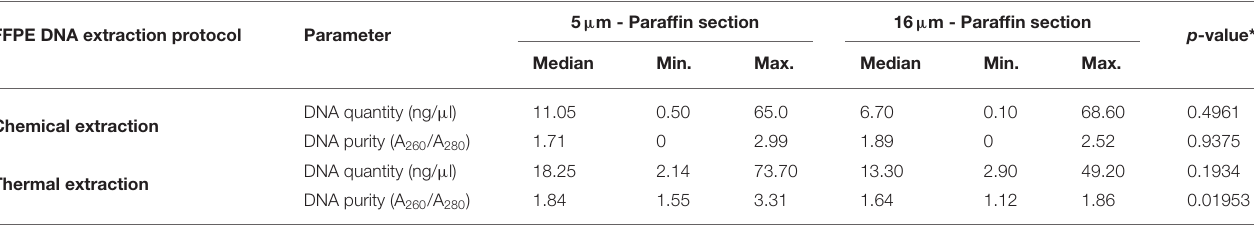
TABLE 2A | Comparison of chemical and thermal DNA extraction protocols in clinical FFPE skin samples from ten cats, using the two paraffin sectioning protocols (5 and 16 µ m), in relation to the DNA concentration (ng/ µ L) and the degree of DNA purity (A 260 /A 280 nm ratio). FFPE DNA extraction protocol